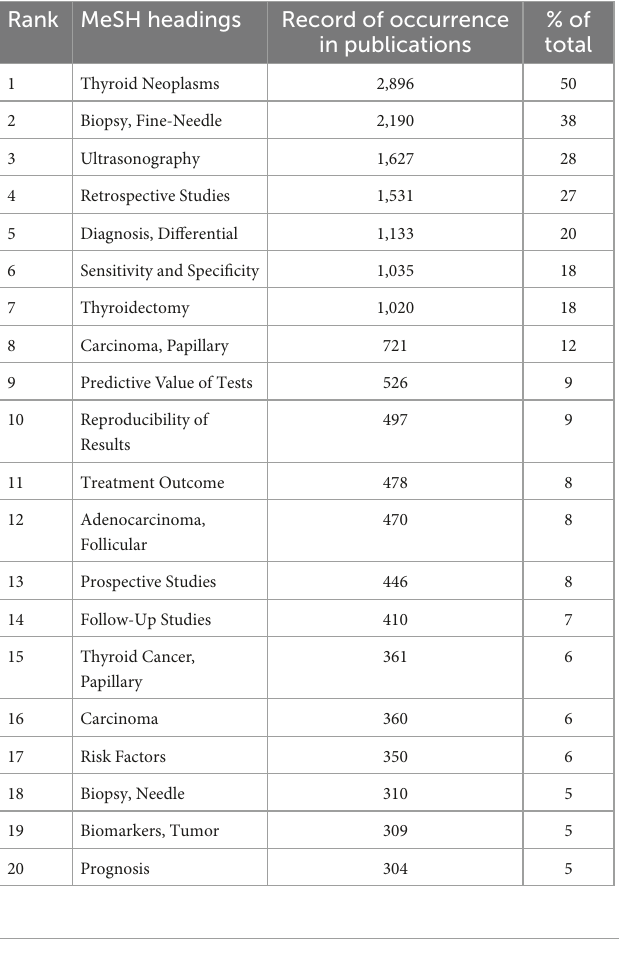
TABLE 1 Overall ranking of research foci in the past 22 years.